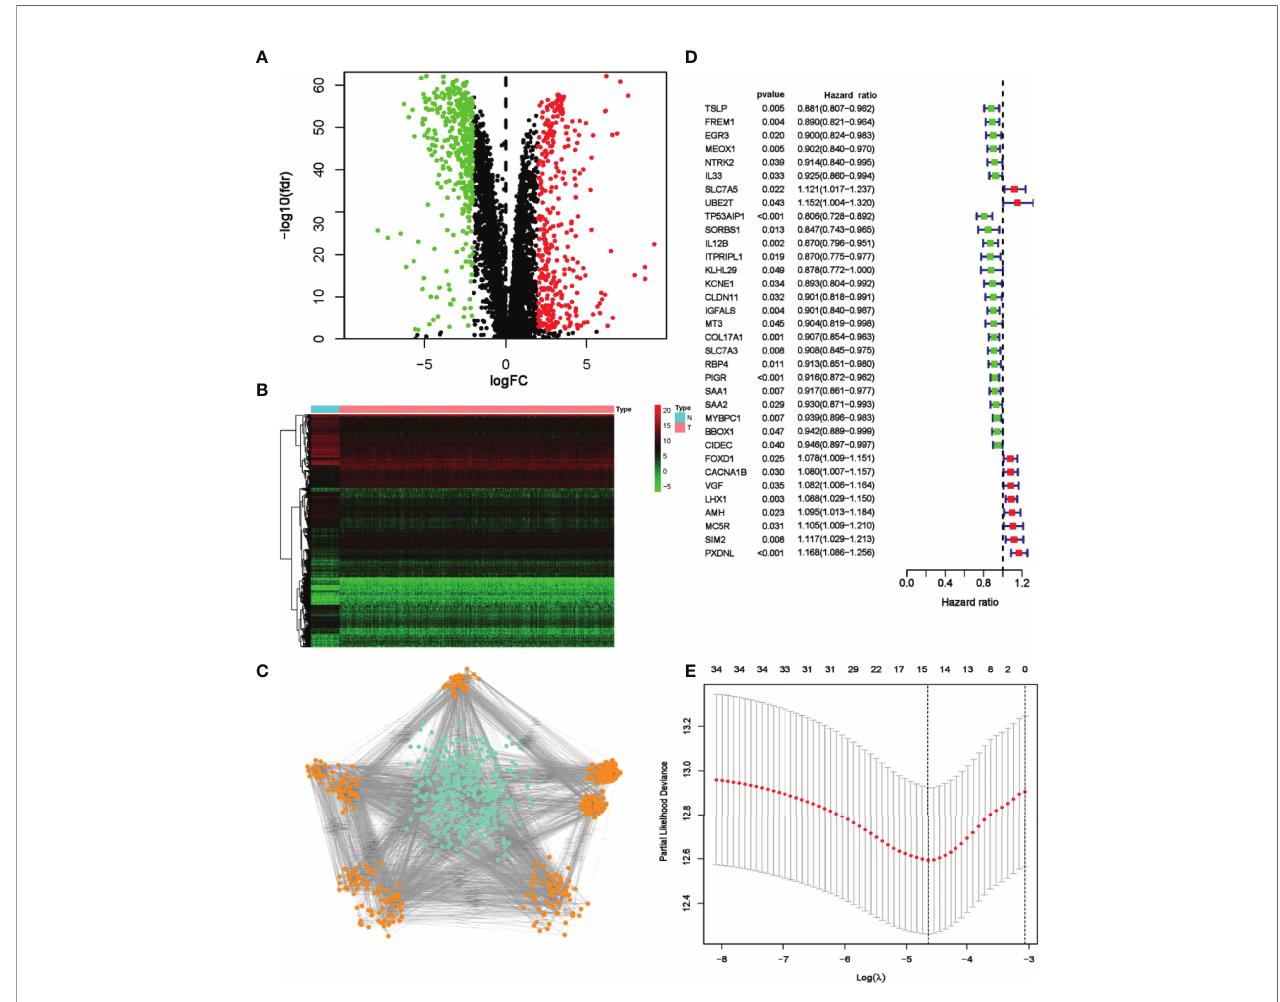
FIGURE 2 | Screening and identi fi cation of prognostic DRGs of TCGA breast cancer patients. (A) Volcano map visualizes DEGs between breast cancer and normal tissues. Red dots indicate upregulated genes, green dots indicate downregulated genes, and black dots indicate no differences gene; (B) Heatmap analysis of differential DRGs; (C) MCODE analysis from the PPI network. The orange nodes represent genes in signi fi cant module, while the blue nodes represent genes in insigni fi cant module. (D) Forest plot of 34 genes identi fi ed by the univariate Cox regression analysis. (E) LASSO coef fi cient pro fi les of 15 prognosis-related genes. The red dots represent the partial likelihood values. The optimal parameter ( l ) was calculated by ten-fold